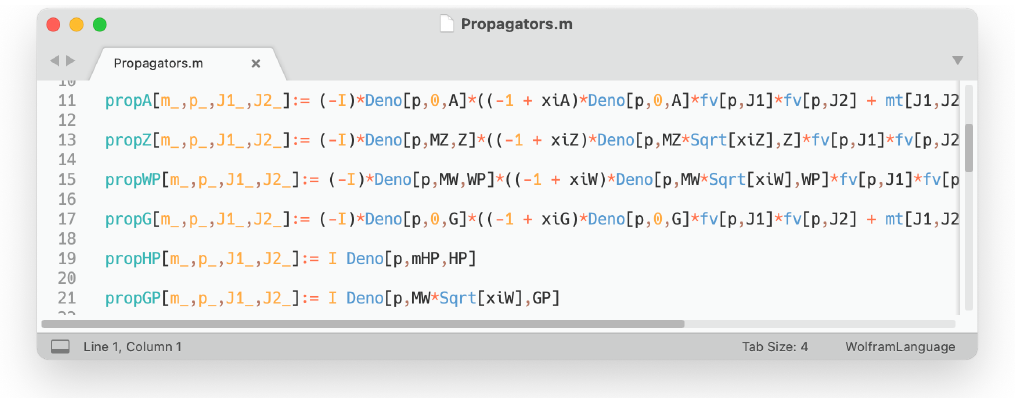
Figure 10 . Excerpt from the modified Propagators.m file of the C2HDM, containing the Feynman rules for the propagators written in a FeynCalc -readable